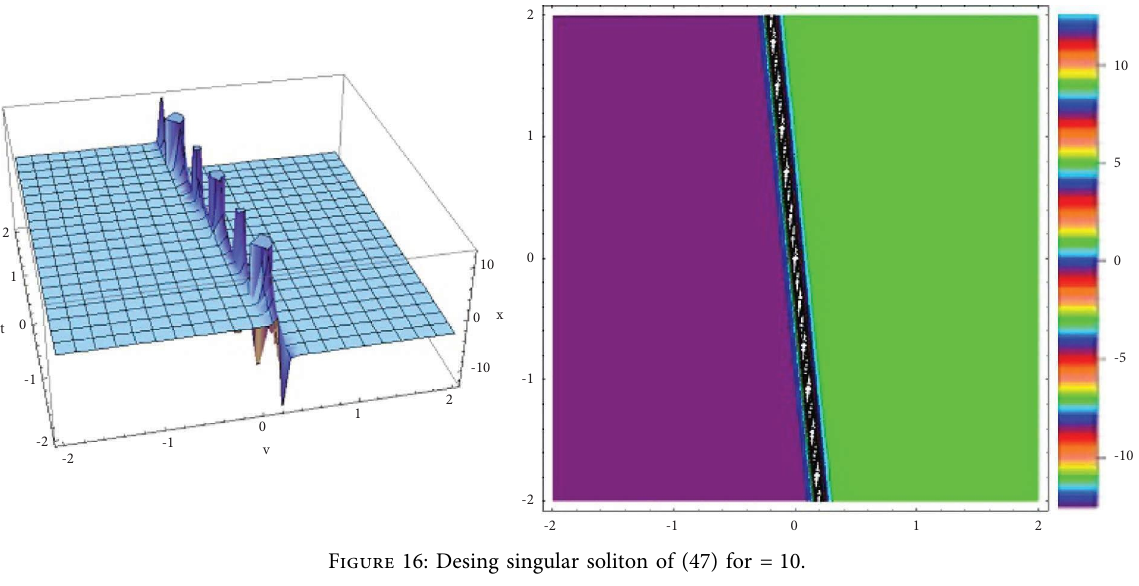
Figure 16: Desing singular soliton of (47) for �